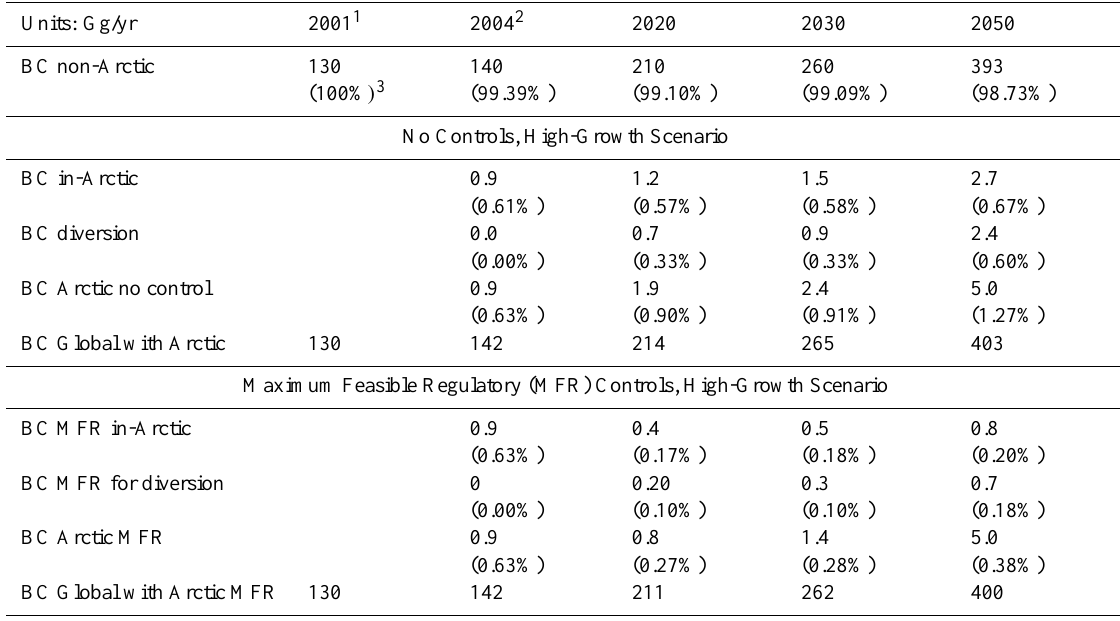
Table 14. BAU-growth scenarios for black carbon, with and without emissions